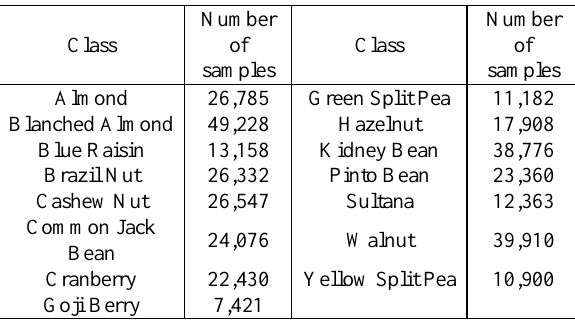
Table 1. Overview of the used object types for acquiring the Cubert dataset.